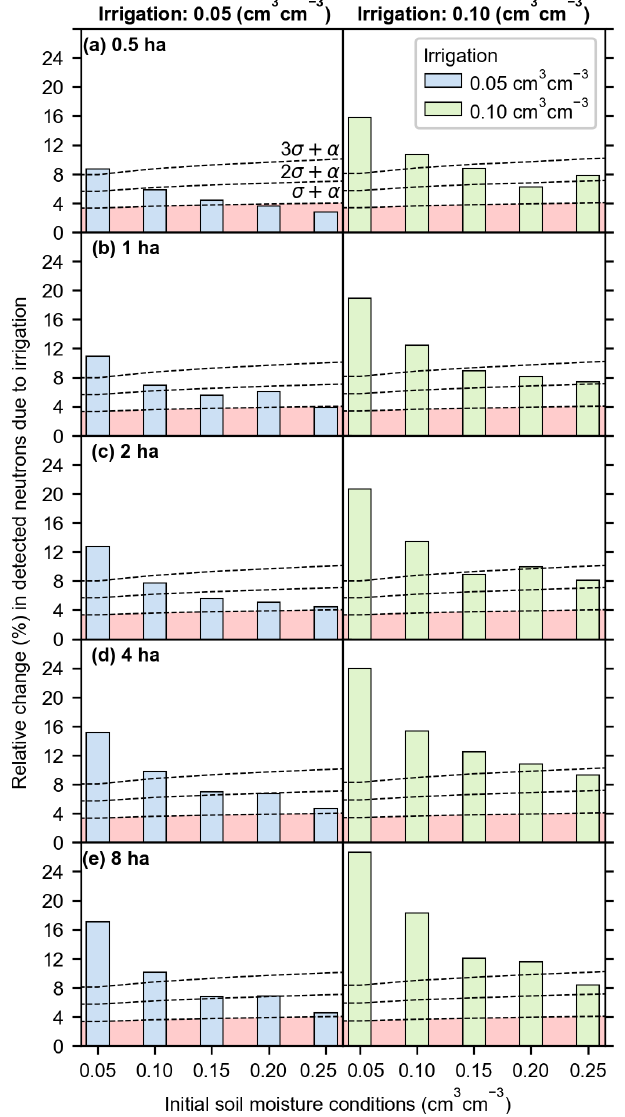
Figure 8. CRNSs’ chance of detecting irrigation events of 0.05 and 0.10cm 3 cm − 3 (blue and green bars, respectively) in (a) 0.5, (b) 1, (c) 2, (d) 4, and (e) 8ha irrigated fields. The bars show the rel- ative change in detected neutrons induced by the irrigation event, while the dashed black lines show the prescribed detection certainty thresholds. The red area below the σ + α threshold indicates uncer- tain